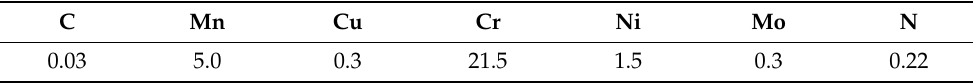
Table 3. Chemical composition (wt%) of the DSS, UNS